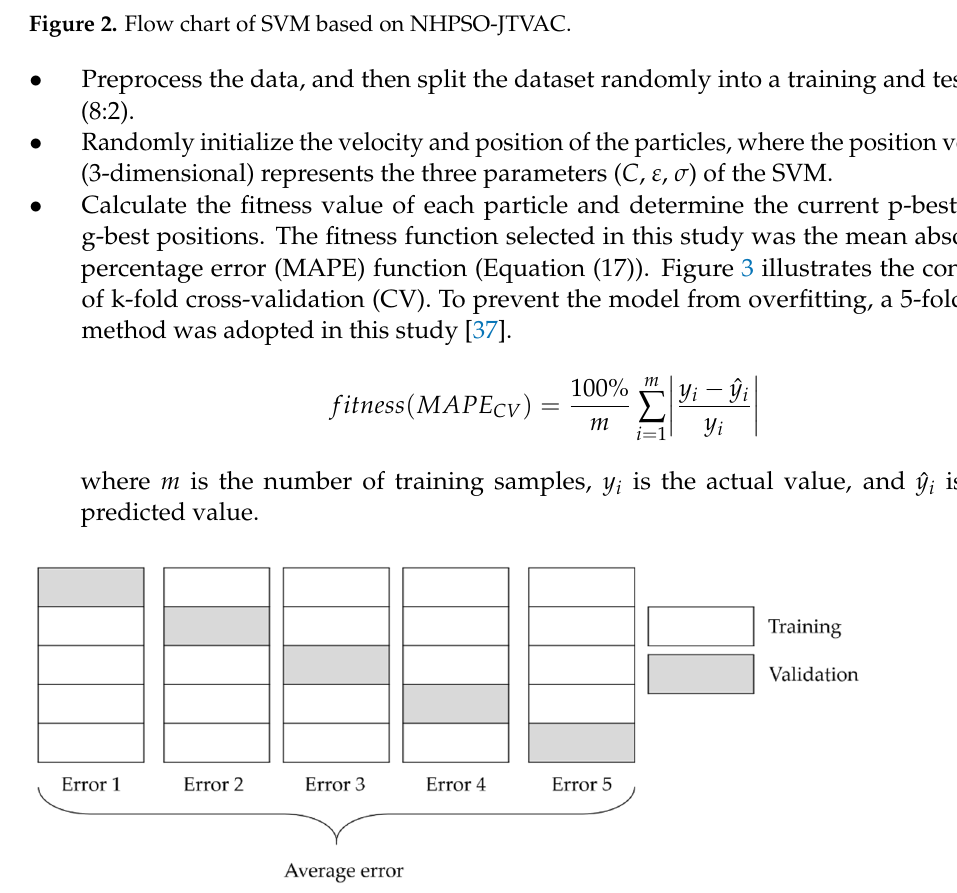
Figure 3. Concept of k-fold cross-validation (k =